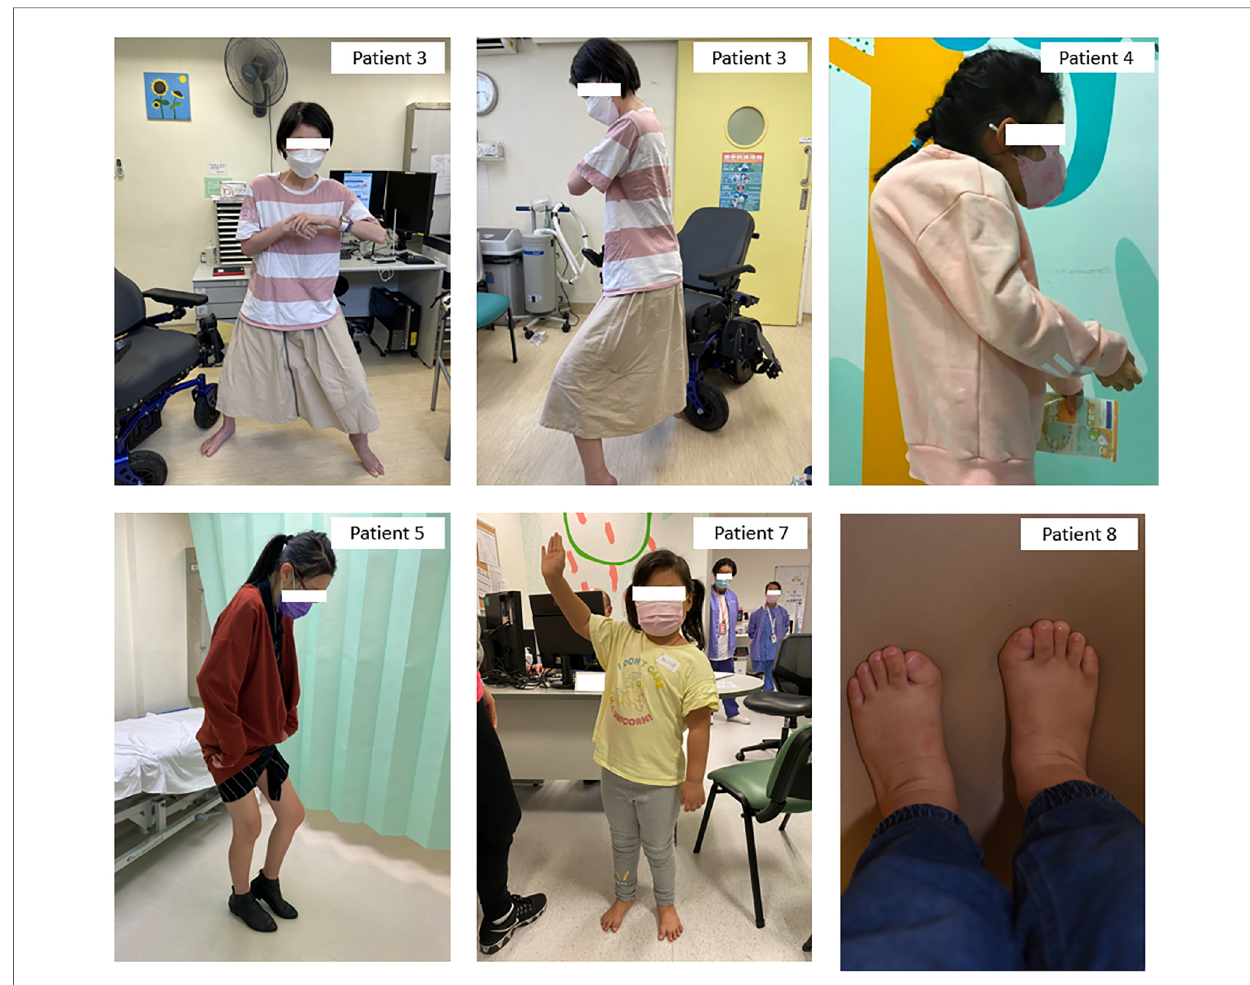
FIGURE 2 Clinical photos of Patients 3, 4, 5, 7, and 8. Patient 3: Bilateral shoulder and left elbow contractures with inability to raise hands above shoulder level, also bilateral hip and knee fl exion contractures resulting in stooped posture even during walking, depends on powered wheelchair for mobility. Patient 4: Bilateral shoulder and elbow contractures and severe kyphoscoliosis with impending chin-on-chest deformity. Patient 5: Unaffected lower limbs but fully ankylosed spine from cervical to lumbar in kyphotic position, needs to stand with hips and knees fl exed to maintain balance. Patient 7: Limited right shoulder abduction with decreased range of motion and other joints are minimally affected otherwise. Patient 8: Characteristic big toe deformity with hallux